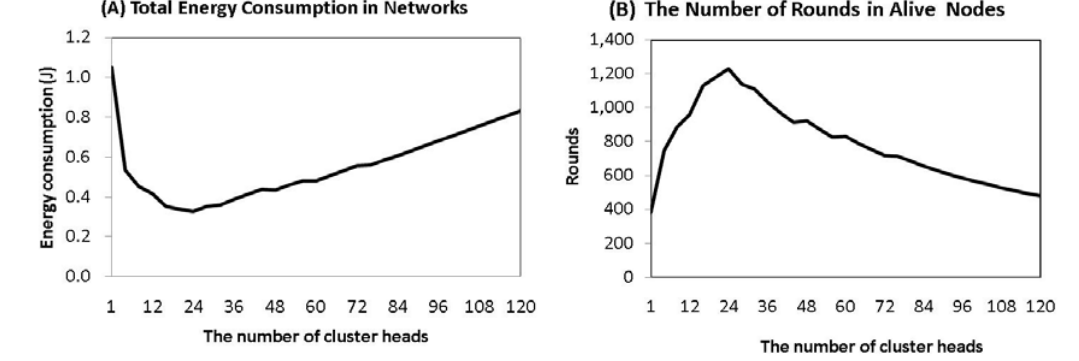
Figure 4. Energy consumption and node alive. (A) total energy consumption in the network, (B) the number of rounds in alive